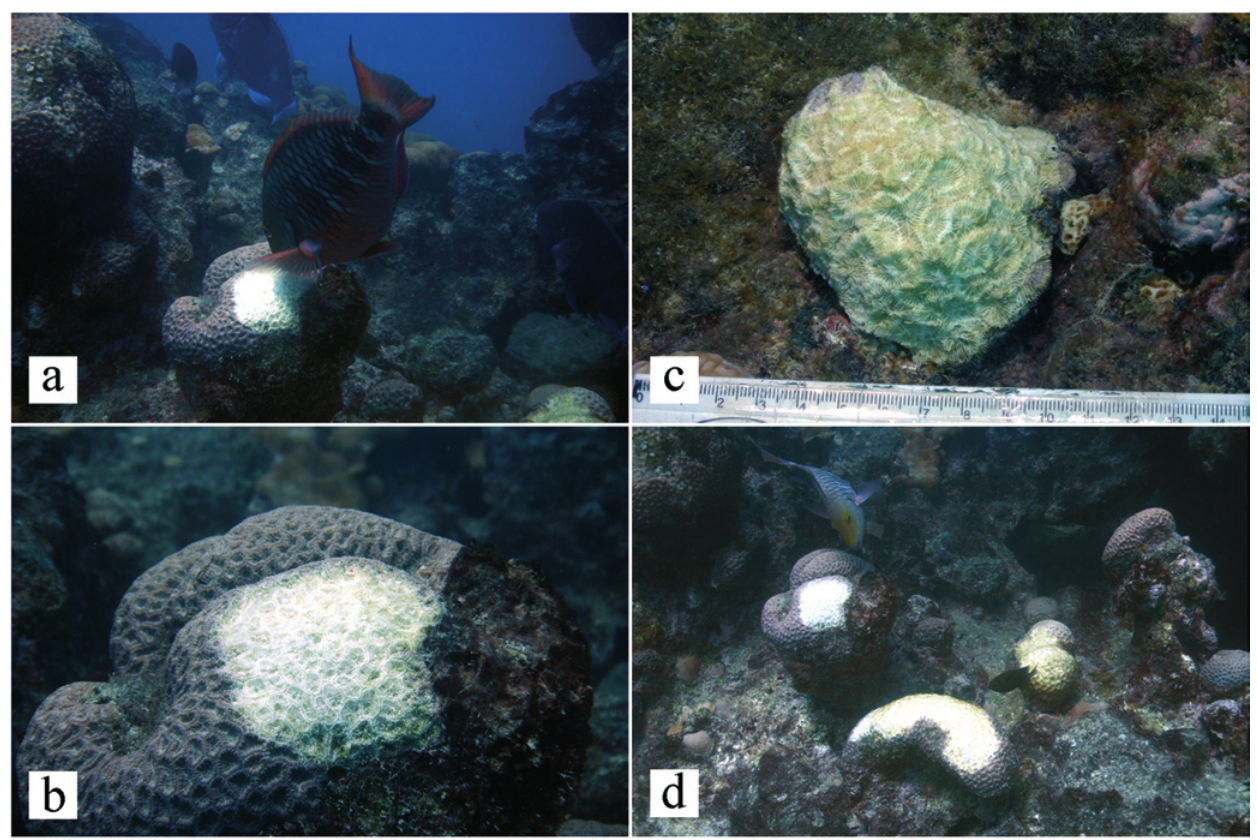
Fig. 3. Focused biting behavior by Sparisoma amplum . (a) Initial-phase individual biting a colony of Mussismilia braziliensis ; (b) partial and (c) almost complete coral colony mortality due to Sp . amplum predation; (d) a discrete group of excavated colonies of M . braziliensis on the edge of a Sp . amplum